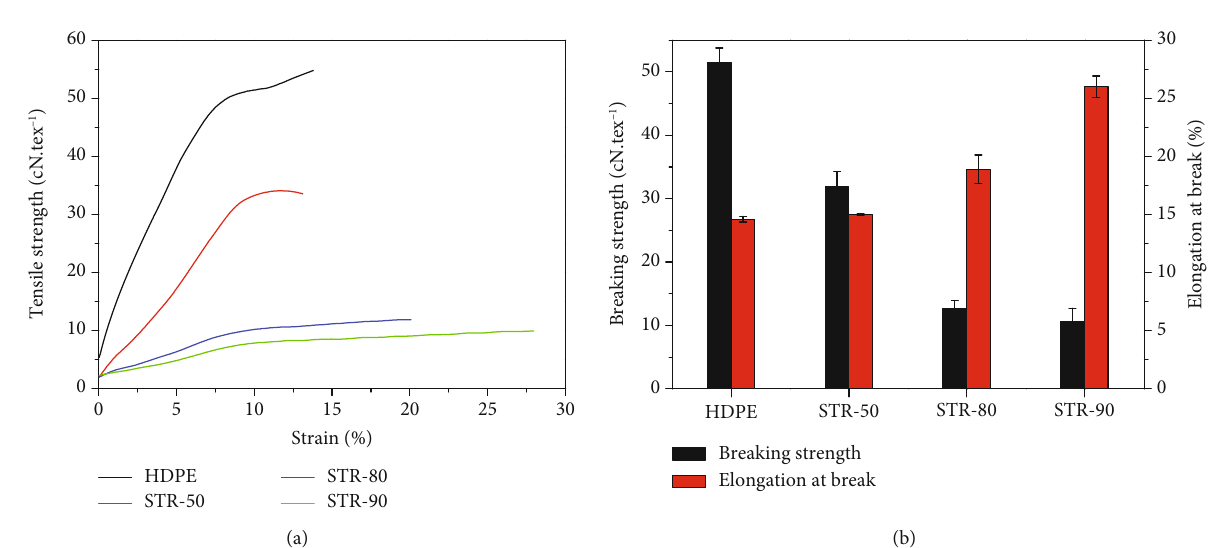
Figure 6: (a) Tensile strength-strain curves and (b) breaking strength and elongation at break of starch-based composite fi